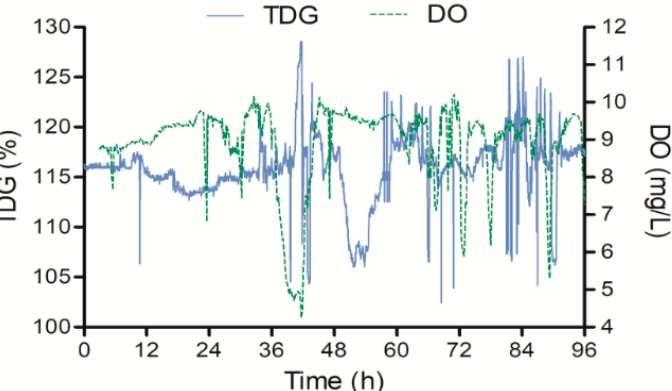
Figure 2. The values of total dissolved gas (TDG) and dissolved oxygen (DO) in the 96-h observation period.